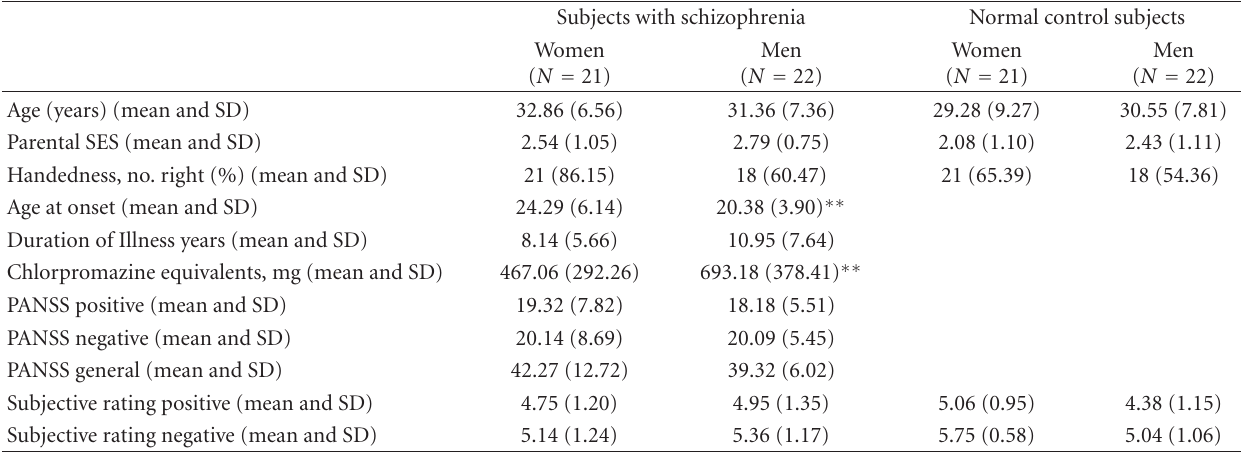
Table 1: Sociodemographic and clinical